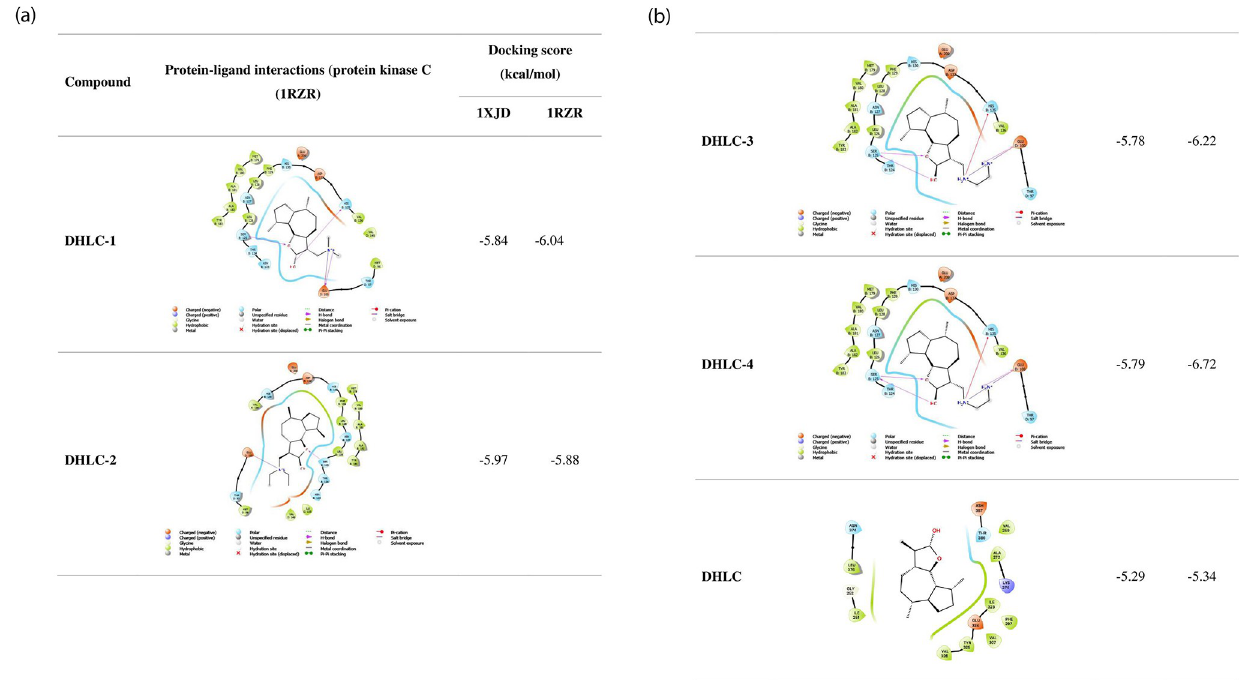
Fig 4. Molecular docking affinities of 13-amino derivatives of dehydrocostus lactone using protein kinase C (1RZR) and PKC theta (1XJD) enzymes.